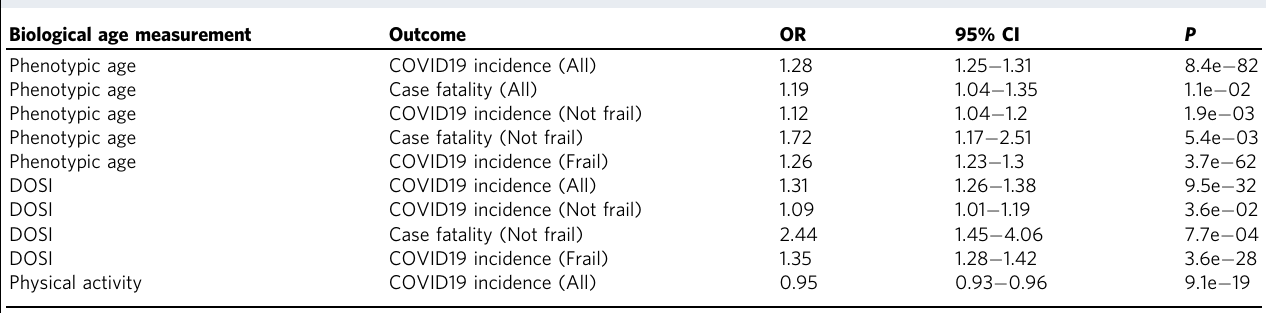
Only the associations that reached nominal signi fi cance ( P <0.05) are